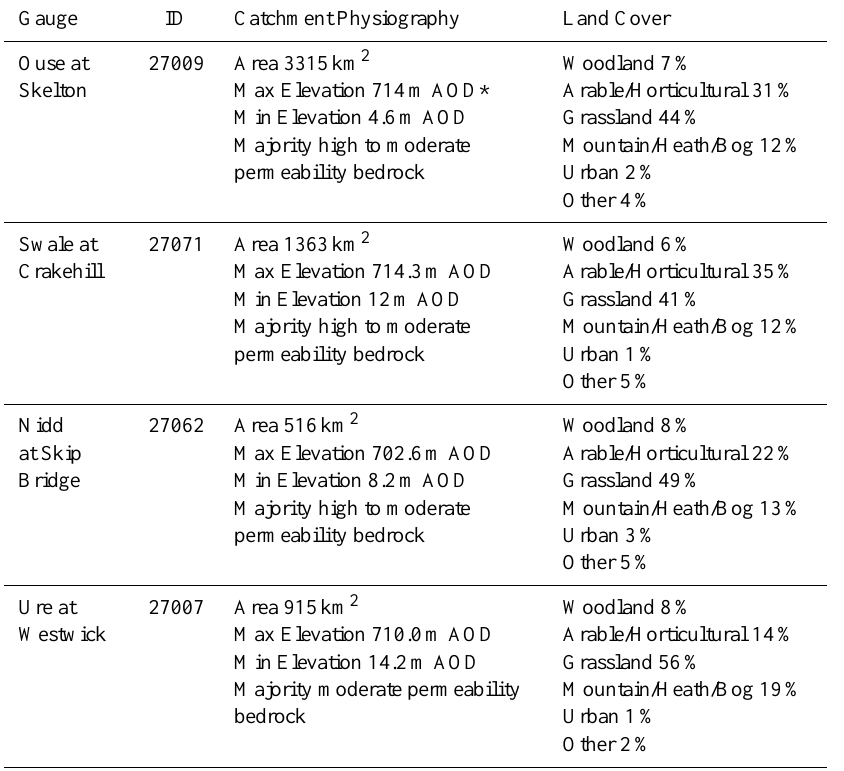
Table 1. Description of the River Ouse catchment and its primary sub-catchments.